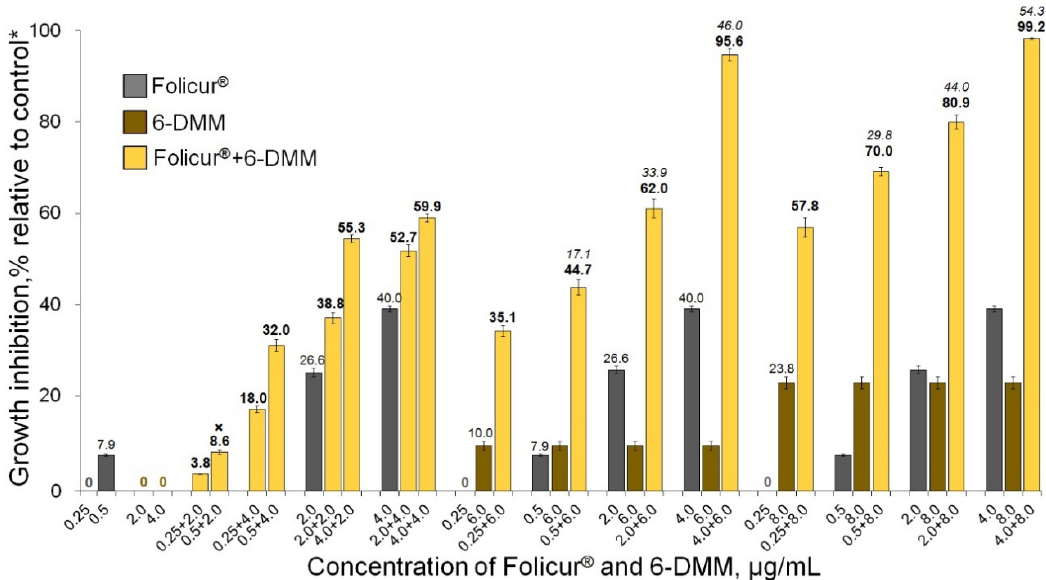
Figure 3. Enhancing the inhibitory effect of Folicur ® EC 250 on the in vitro growth of Bipolaris sorokiniana due the fungicide combination with 6-DMM. The numbers in bold or regular above the columns indicate E r values, while italic numbers show E e values related to the same fungicide/6-DMM concentration combination. E r shows the inhibition of the fungal growth (%) when the fungicide and 6-DMM were co-applied; E e is the inhibition calculated for an estimated additive effect of the fungicide and 6-DMM (%). In the case when E r > E e at p ≤ 0.05, a synergistic interaction between the fungicide and the sensitizer is confirmed (see Materials and Methods, Section 4.4 and [31]). The case of an additive effect is marked with “ × ”. Each histogram column represents the mean of three experiments (two diameter measuring of each colony, three colonies per each individual or combined application in each of three independent assays). Y-bars indicate standard error (SE) of the mean. The difference between treatments is significant at p ≤ 0.05 ( t -test for independent variables). * Control colonies were cultured on potato dextrose agar free of 6-DMM and the fungicide.